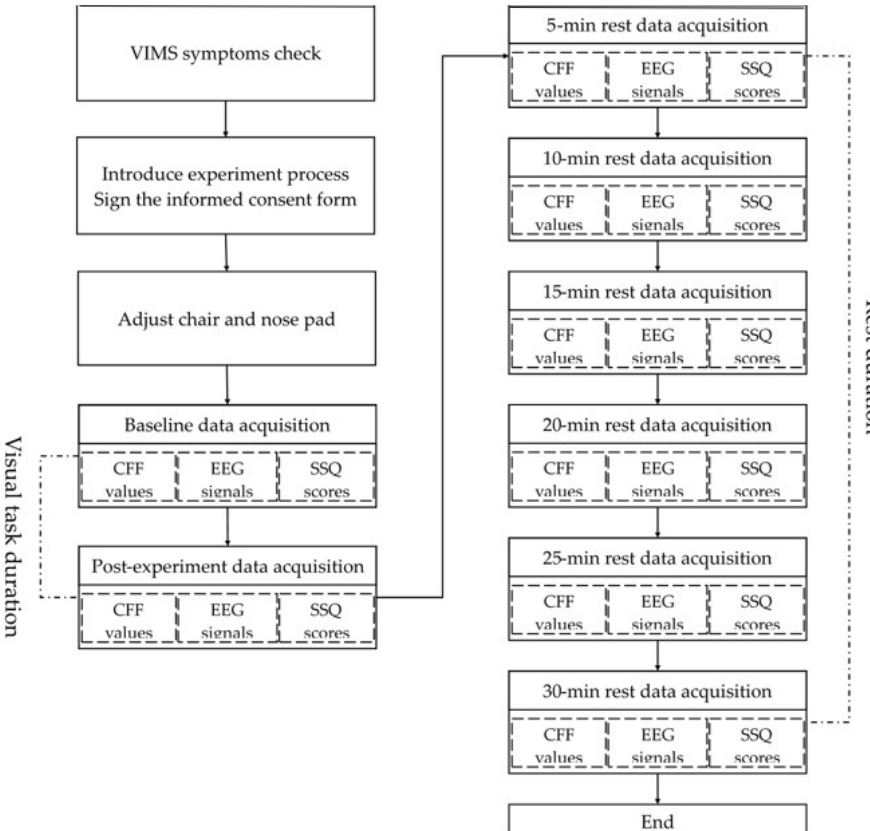
Figure 2. The experimental procedure sequence in this study.